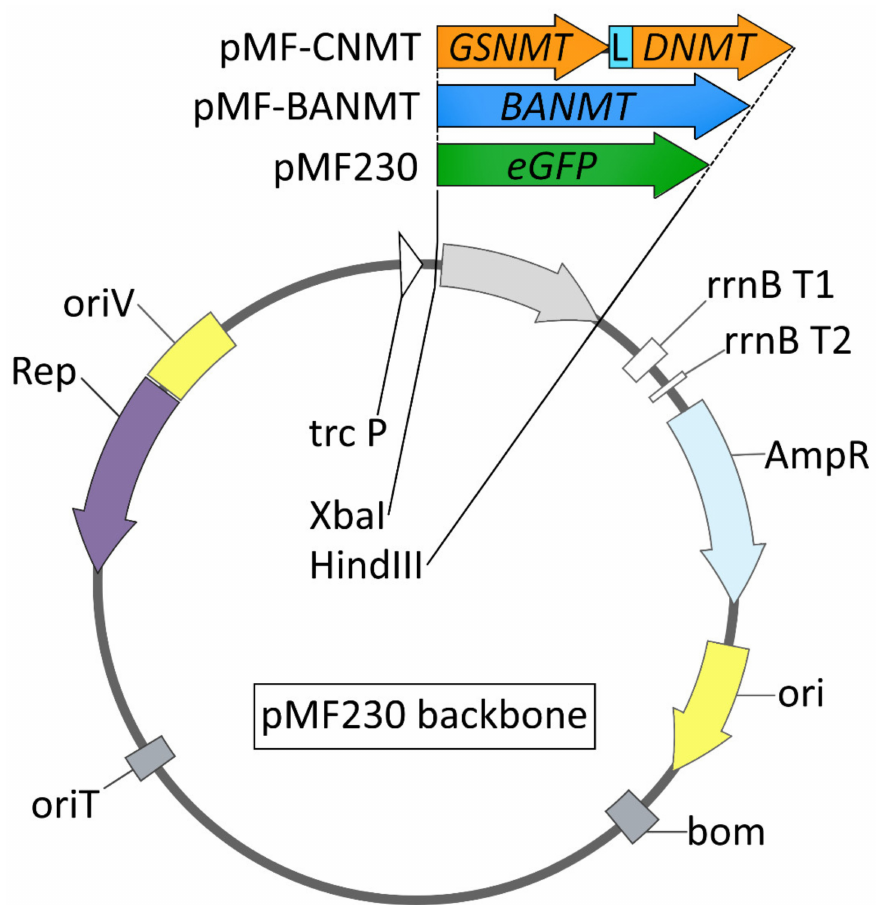
Figure 1. Schematic representation of plasmid vectors used in this study: trc P, hybrid pro- moter; lac, lac operator; rrnB T1, rrnB T2, transcription terminators from rrnB gene; AmpR P, β -lactamase gene promoter; AmpR, β -lactamase gene; ori, ColE1 origin of replication; bom, basis of mobility region from pBR322; oriT, incP origin of transfer; oriV, broad-host-range origin of replication from Pseudomonas aeruginosa plasmid pRO1600; Rep, replication protein gene for the pRO1600 plasmid; eGFP , enhanced green fluorescent protein; BANMT , β -alanine N -methyltransferase gene from Limonium latifolium ; GSNMT , glycine sarcosine N -methyltransferase gene from Aphanothece halophytica ; DNMT , dimethylglycine N -methyltransferase gene from A. halophytica ; L, the sequence, encoding the Gly-Gly-Gly-Gly-Se [(GGGGS)x3] linker peptide (the fusion of GSNMT , L , and DNMT creates an in-frame chimeric N -methyltransferase gene, CNMT